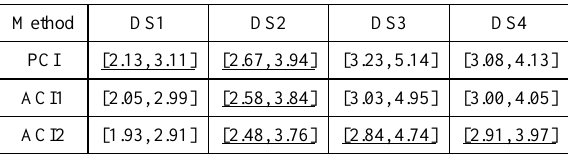
Table 5. The estimation results of model parameter 𝛽 with BS2